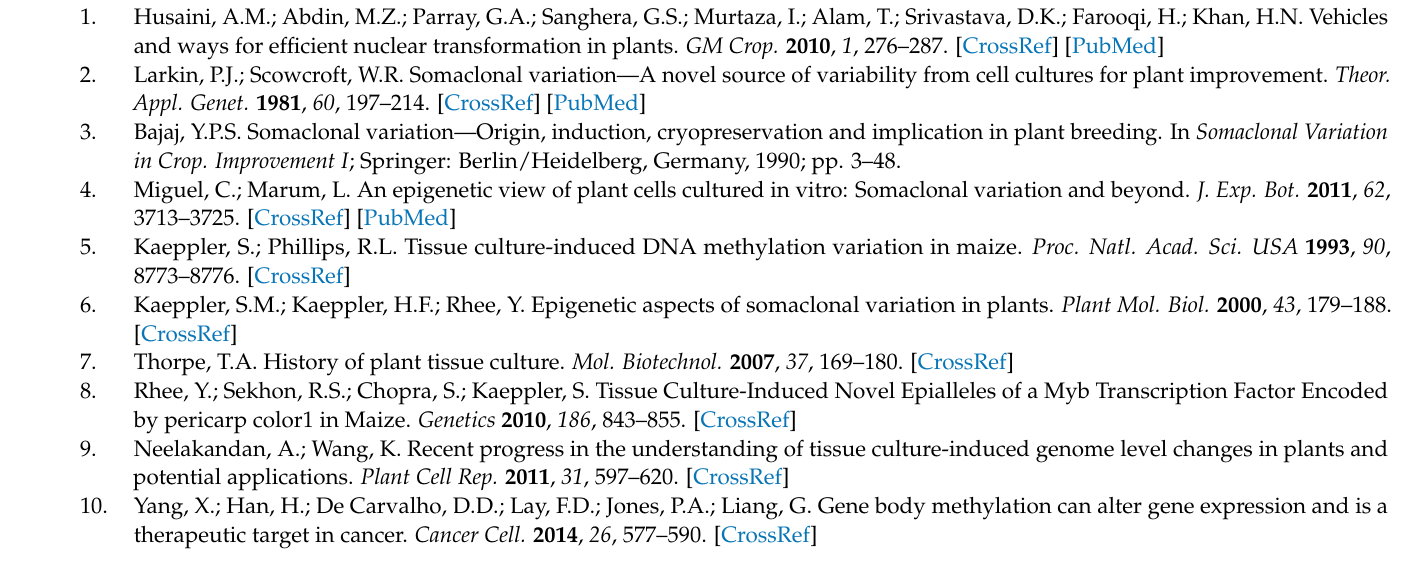
primer sets for transformant-conserved DMRs (TCDs). Table S1. List of primer sets for quantitative RT-PCR analysis. Table S2. List of primer sets for methylation-specific PCR analysis. Table S3. Average methylation level in total genome of the non-transgenic and transgenic lines. Table S4. List of genes within the conserved DMRs identified in the transgenic